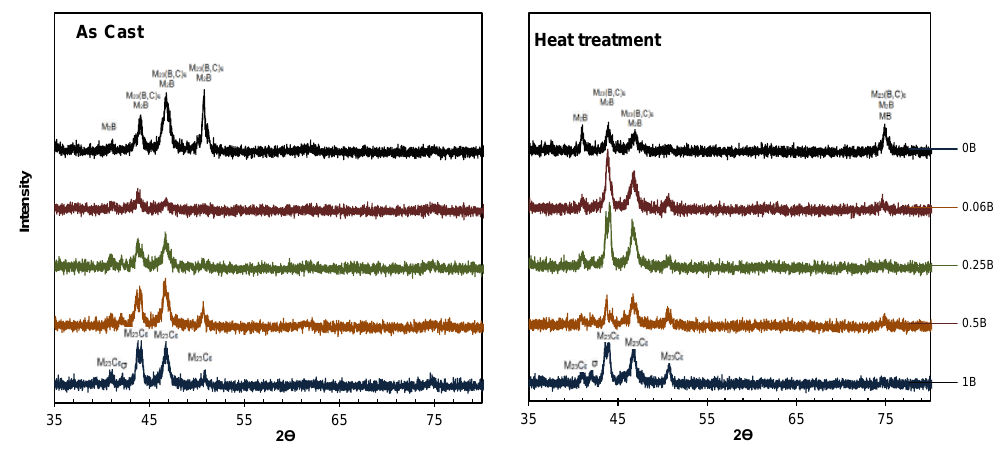
Figure 4. X-ray diffraction patterns of the studied alloys.